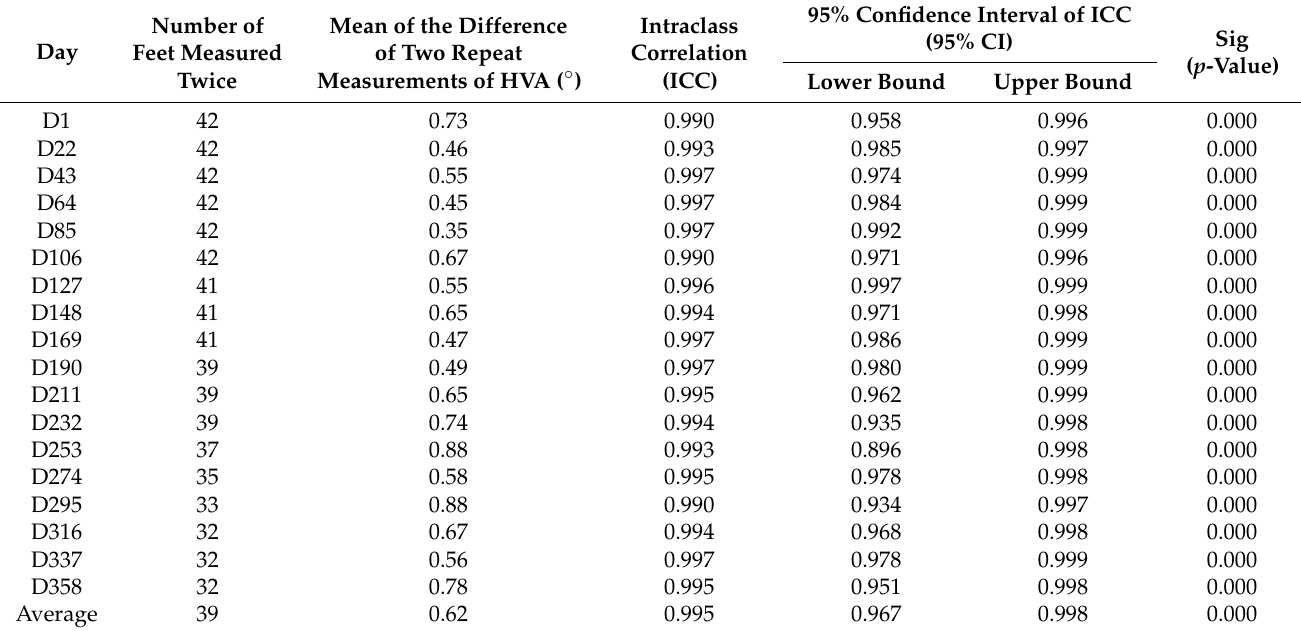
Table 1. Manual measurement and analysis using test–retested reliability and intraclass correlation coefficient